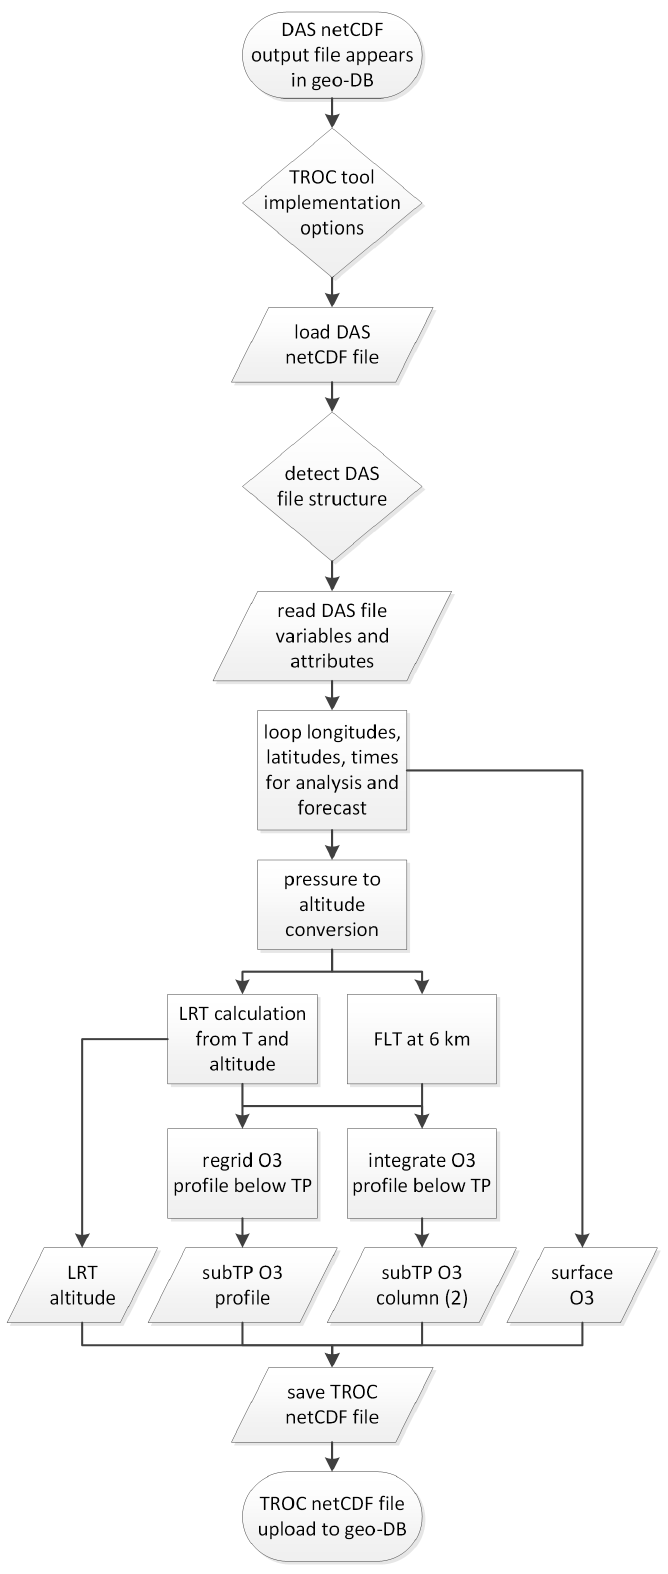
Figure 9. Schematic flowchart representation of the tropospheric ozone calculation (TROC)